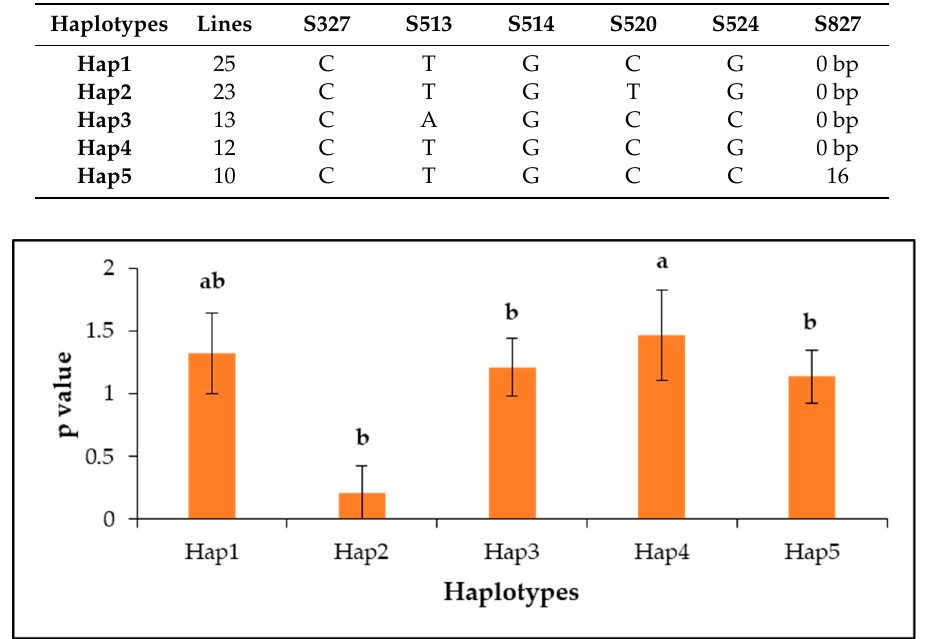
Figure 7. Effect of haplotypes consisting of five significant loci on low-phosphorus tolerance index of dry weight of roots in 111 inbred lines and a, b and ab represented the significance difference.